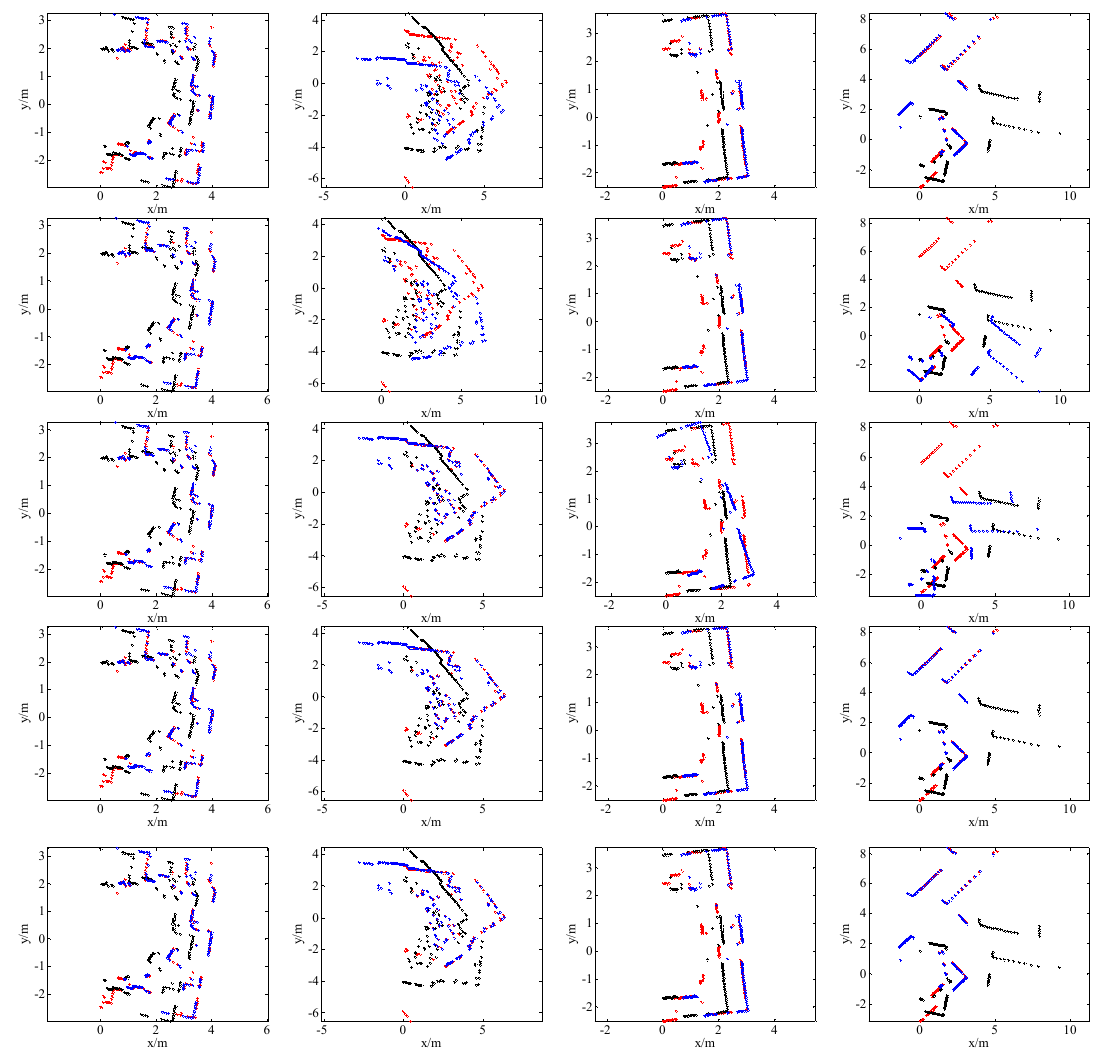
matrix, respectively.